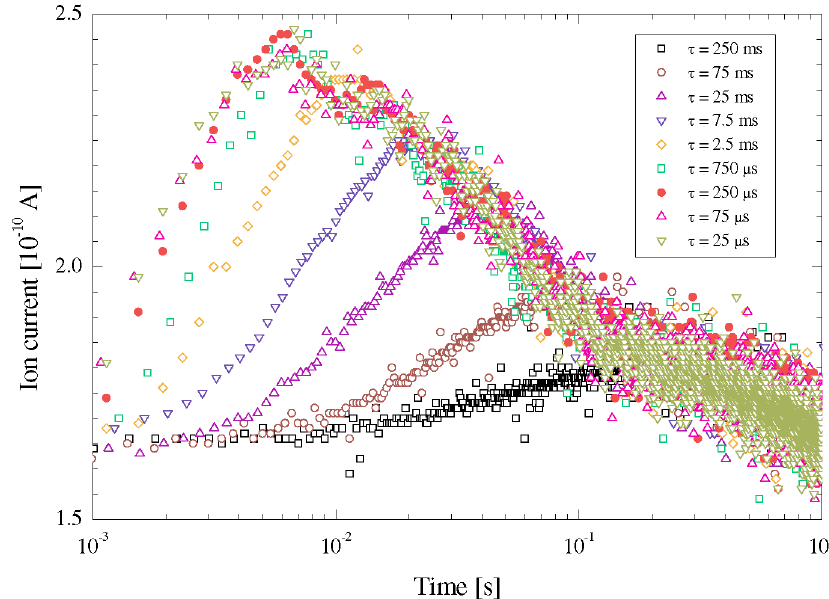
FIG. 3. (Color) Measurement of the development of m=e (cid:6) 28 peak with the residual gas analyzer as a function of time after impact of a shot of Pb 53 (cid:1) when chamber Awas exposed to repeated pulses every 1.2 s. The inset gives the RGA setting (integration time of the electronics) for the various